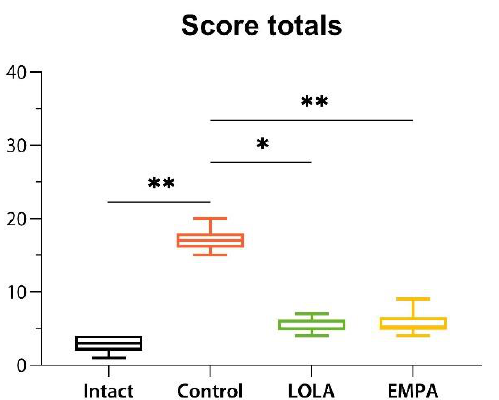
Figure 6. Score totals indicating the overall severity of liver disease. * p < 0.05; ** p < 0.01.